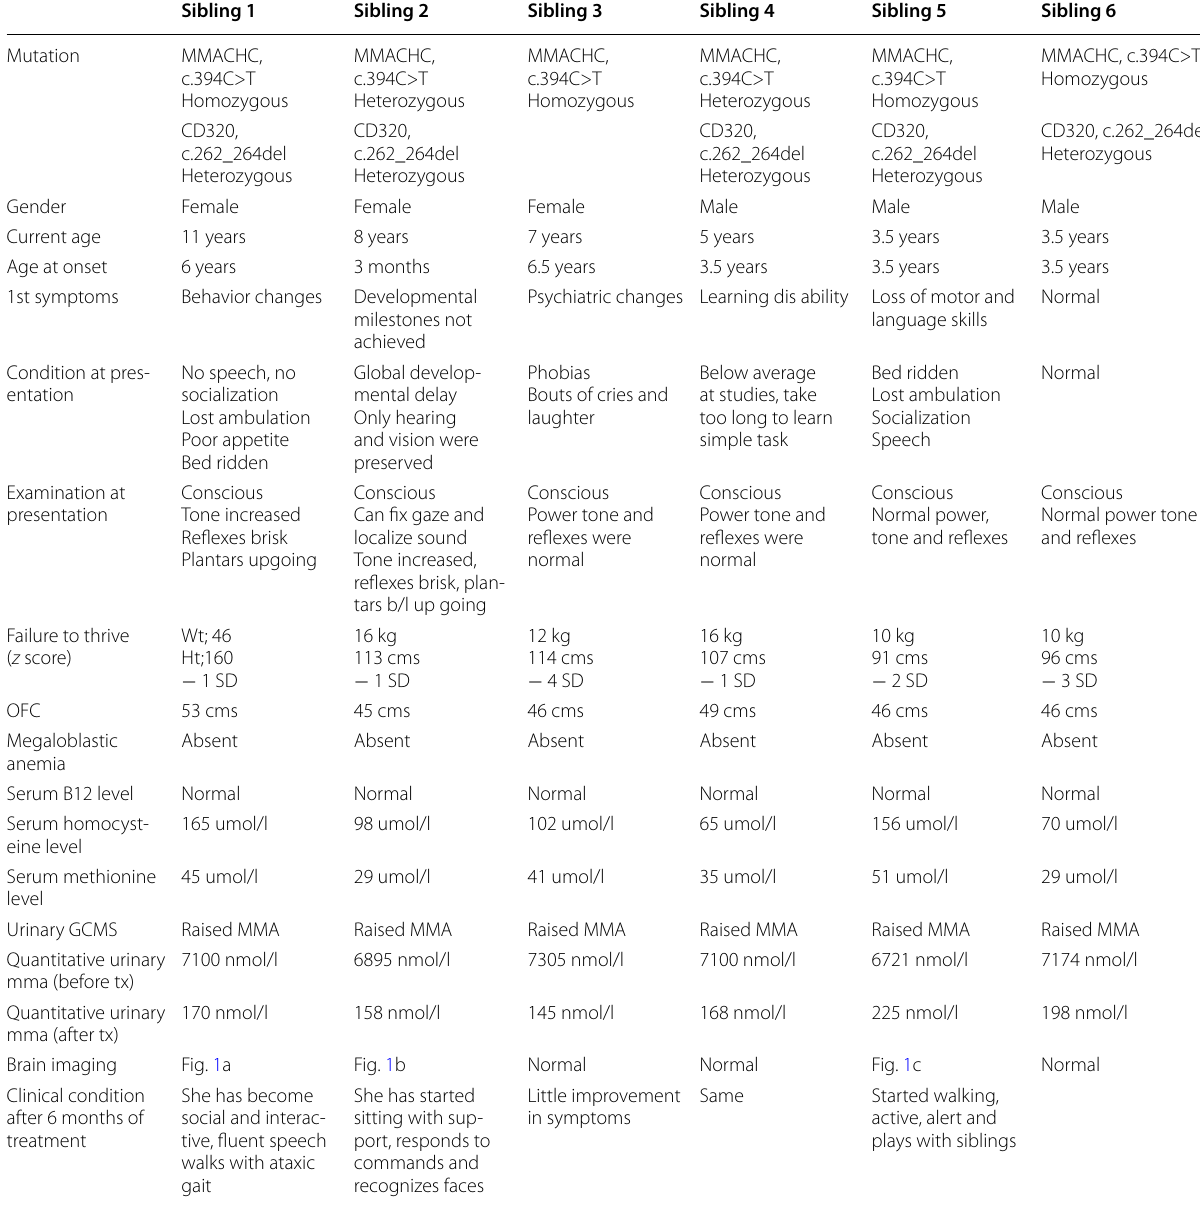
Table 1 Clinical manifestation, laboratory parameters and genetic analysis of all